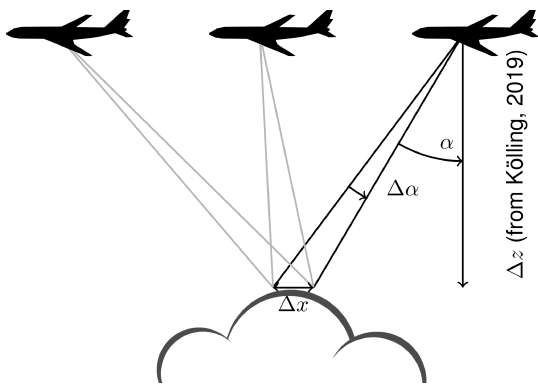
Figure 3. Observation geometry: the same target on the cloud (in- dicated by (cid:49)x ) is observed from different viewing angles ( α ). The cloud top height information needed to calculate the distance (cid:49)z between the target and camera is retrieved using the method de- scribed in Kölling et al. (2019). The single measurements are then aggregated into one radiance measurement of the